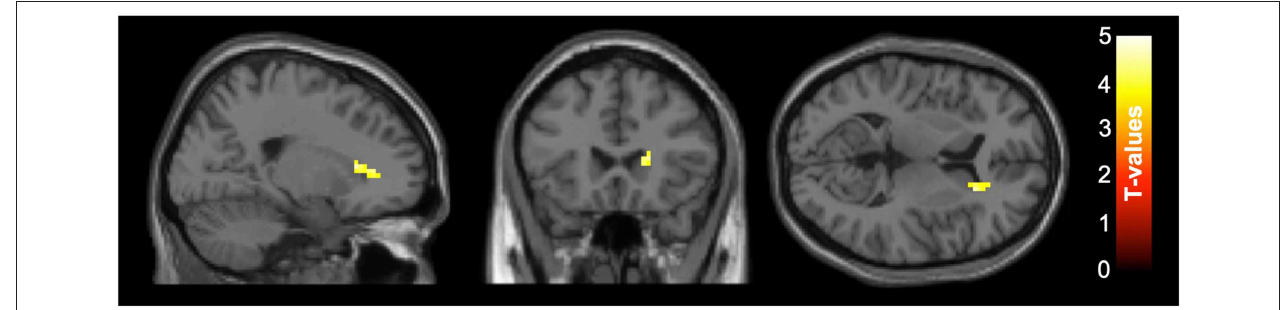
FIGURE 1 | Axial slices of group × time interaction for the functional connectivity between posterior cingulate cortex (PCC) seed and right caudate. After correcting for false discovery rate (FDR), functional connectivity of the PCC at rest increased in the right caudate ( k = 60, p FDRcorrected = 0.046, t = 4.14 [21 24 9]) for the active group compared to the placebo group between baseline and follow-up. The color-bar indicates the t -value, left side is subject’s left side. Slice numbers on the top left of each image represent the standard MNI coordinates in axial